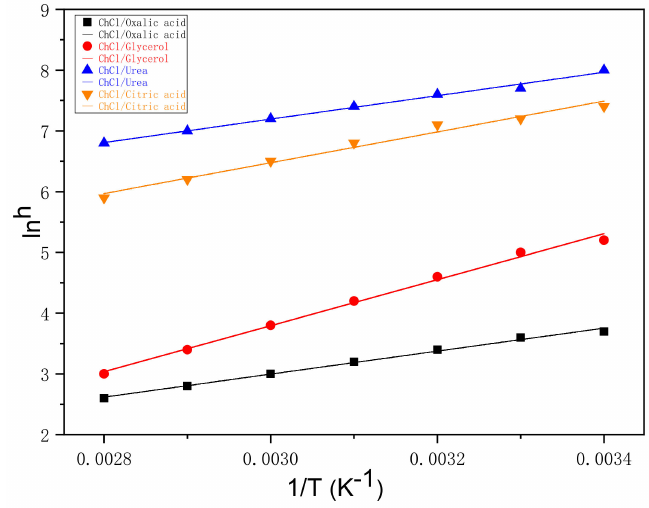
Figure 1. The e ff ect of temperature on the viscosity of